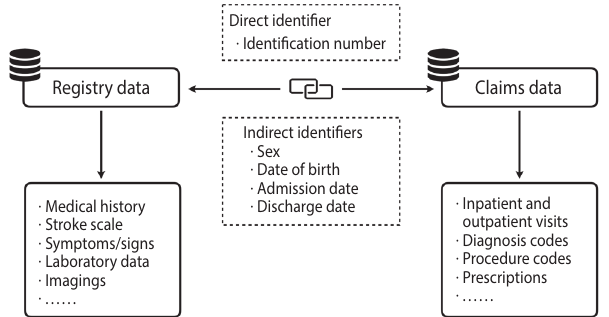
Figure 2. Linkage between registry and claims data using direct or indirect